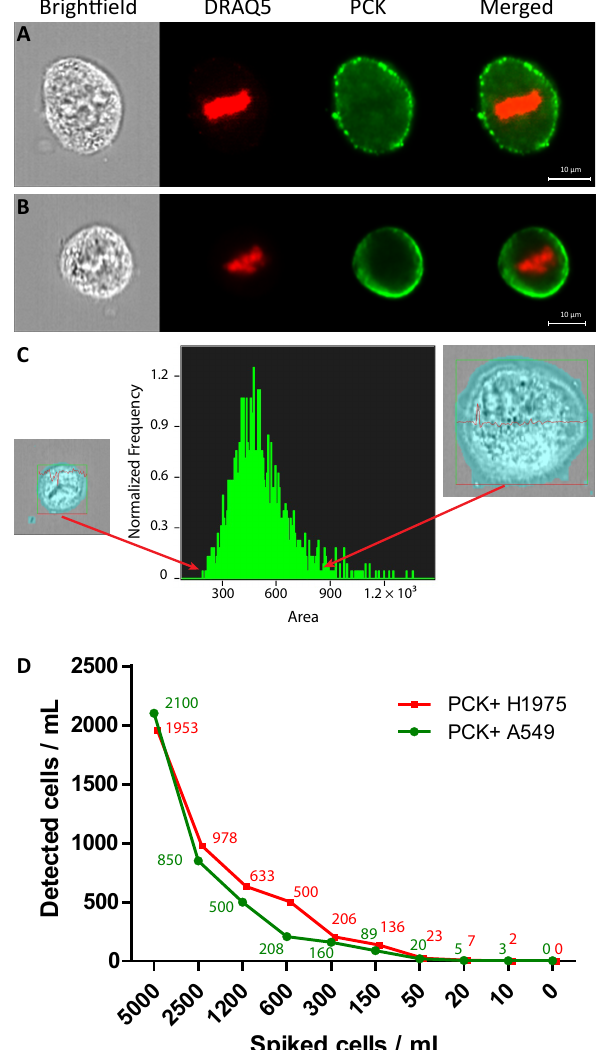
Figure 1. Positive AE1/AE3 staining is signified by a deep green halo encircling the entire A549 and H1975 cells’ cytoplasm. Positive A549 (Panel A ) and H1975 (Panel B ) cells are depicted as having a positive AE1/AE3 (green) staining in addition to positive DRAQ5 (red) staining of the nucleus. (Panel C ) A small and a large H1975 AE1/AE3+ cells. The H1975 cell size is measured in pixels area and expands from 48 pixels = 12 µ m diameter to 104 pixels = 26 µ m diameter. Cell on the left are the smallest cells detected, whereas the cells on the right of the histogram are the largest H1975 cells observed in these samples. Both bright field images are highlighted with a blue mask as the software measured variable statistics for both cells and calculated their size. (Panel D ) Serial dilutions of cell lines (A549 and H1975) spiked in 1 mL of healthy donor blood, retrieved based on AE1/AE3 (PCK+)